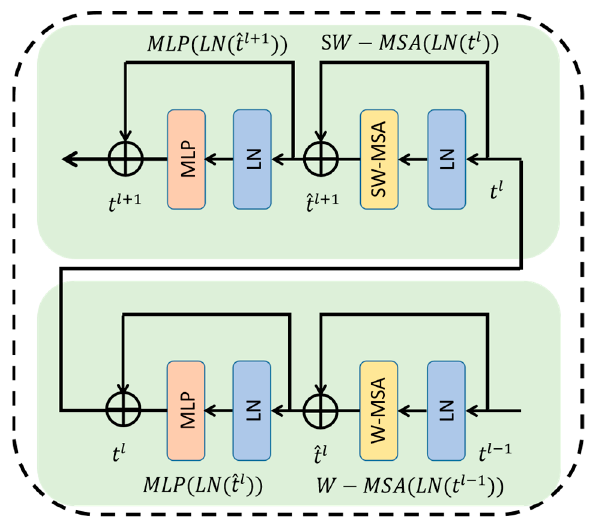
Figure 7. Two successive Swin Transformer blocks.